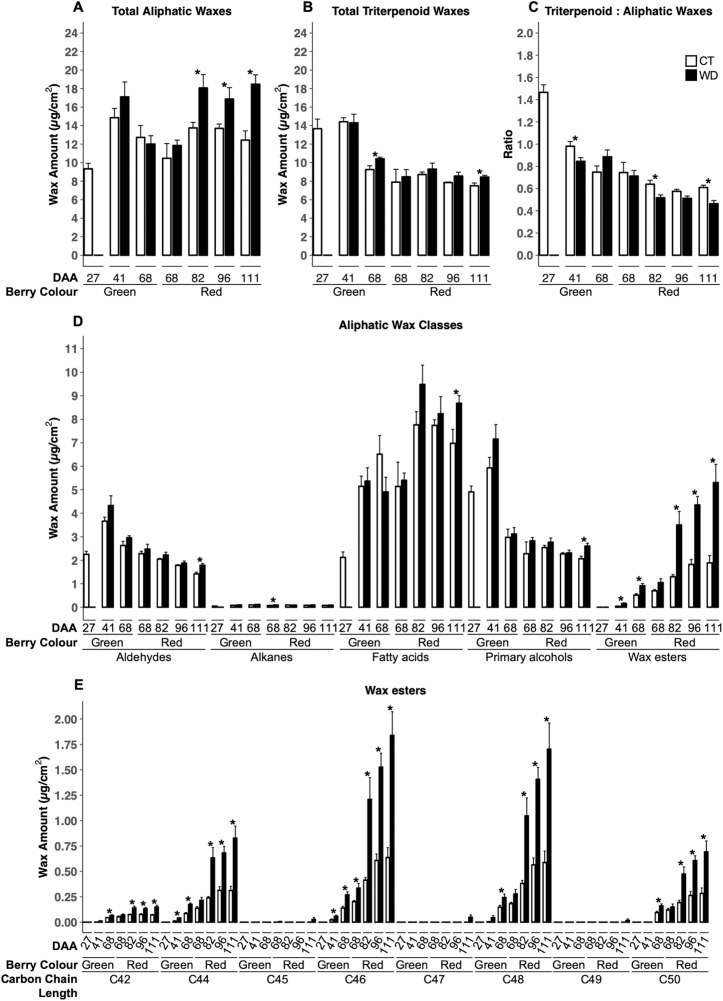
Cuticular wax composition in berries at 27, 41, 68, 82, 96, and 111 days after anthesis (DAA) of grapevines (Vitis vinifera L.) exposed to two irrigation treatments: well-irrigated (control, CT) and deficit irrigated (water deficit, WD). Total aliphatic waxes (A), total triterpenoid waxes (B), triterpenoids:aliphatic waxes ratio (C), individual functional group classes of aliphatic waxes (D), and wax ester composition (E) are reported. Please refer to Supplementary Figs S7–S11 for detailed wax composition of other functional group classes. At 68 DAA, green and red berries were analyzed independently. Error bars represent ±SE, and significant differences between treatments were determined by two-sample t-test (*P<0.05).